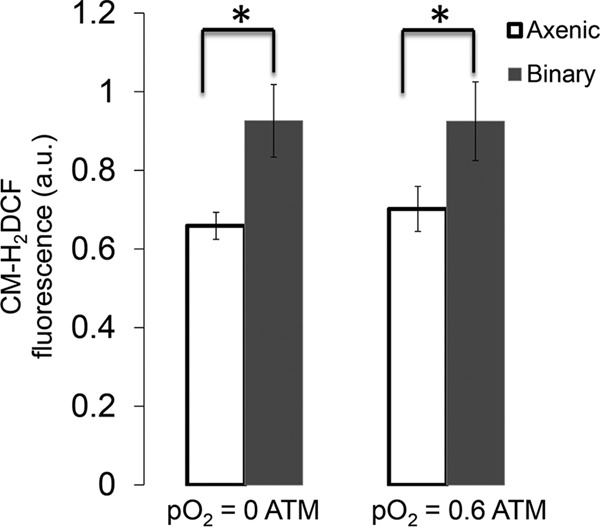
Intracellular reactive oxygen/nitrogen (ROS-RNS) increased under binary cultivation compared to axenic T. elongatus controls. Average intensity (n = 3) of the 525-nm fluorescence emitted from cells excited at 488 nm, corresponding to the abundance of oxidized ROS-RNS reporter dye (CM-H2DCFHDA) for the T. elongatus axenic and binary cultures maintained under low and high oxygen tensions. Error bars represent ±1 standard deviation. *, significant differences with >99% certainty as determined by Tukey’s test.